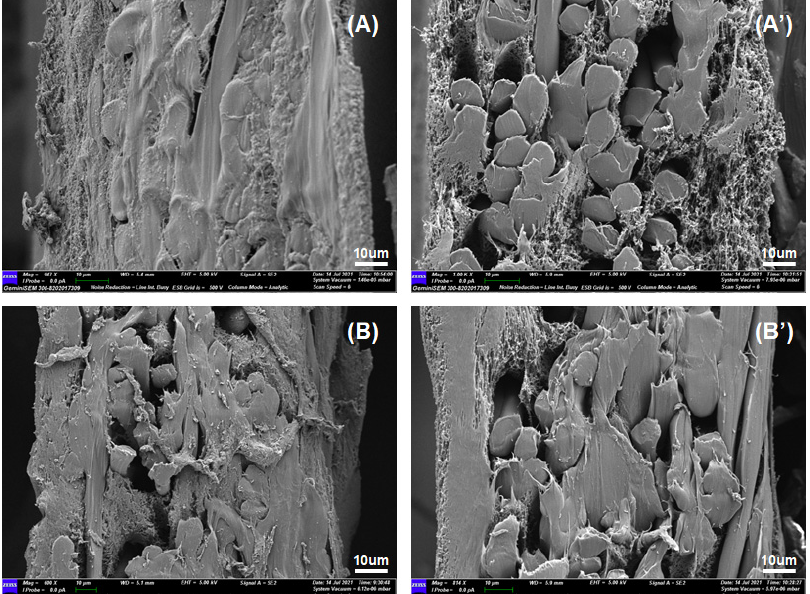
Figure 5. Scanning electron micrographs of HLLC mixture on ( A ) hydrophilic and ( B ) hydrophobic PVDF after polymerization; ( A’ , B’ ) are primitive hydrophilic and hydrophobic PVDF substrates, respectively.